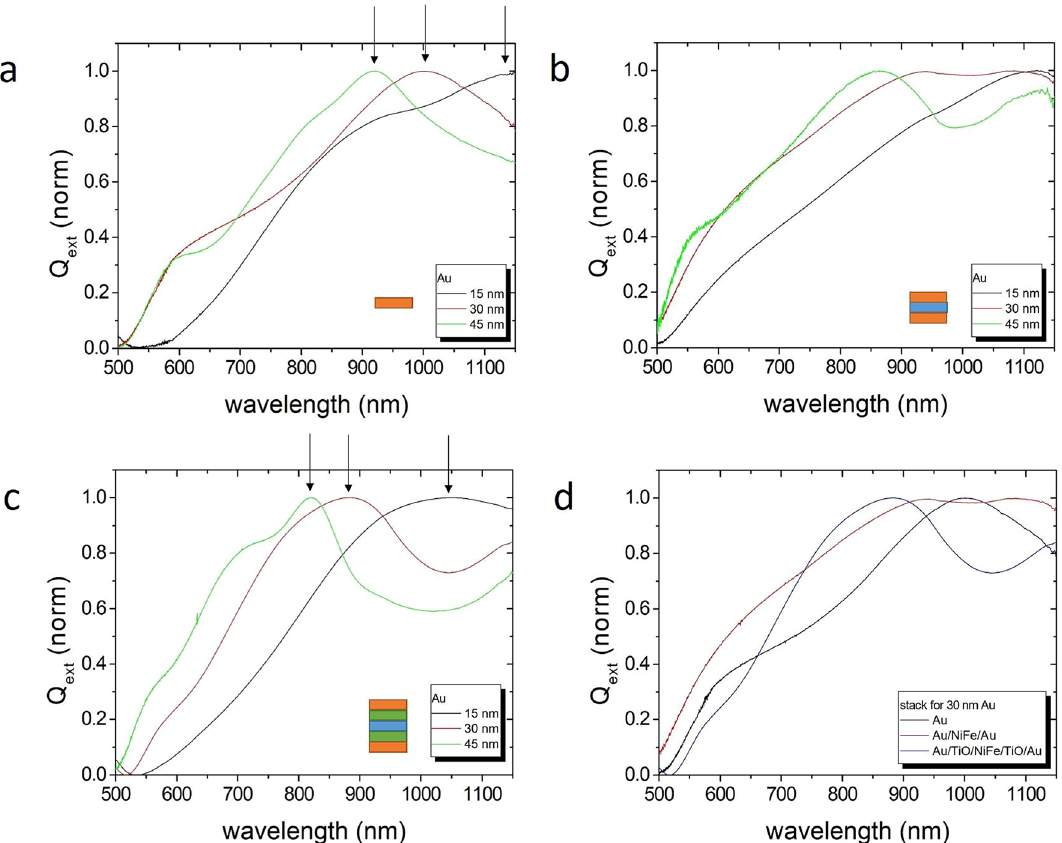
Figure 5. Experimental normalized extinction factors Q ext for different material stacks and Au layer thicknesses (15, 30, and 45 nm) in solution, i.e. with random particle orientation. ( a ) Single Au layer, ( b ) stack without spacer layer: Au/NiFe 10 nm/Au, ( c ) complete stack: Au/TiO 2 10 nm/NiFe 10 nm/TiO 2 10 nm/Au, ( d ) comparison of stacks for 30 nm Au. Absorption maxima are indicated by arrows.